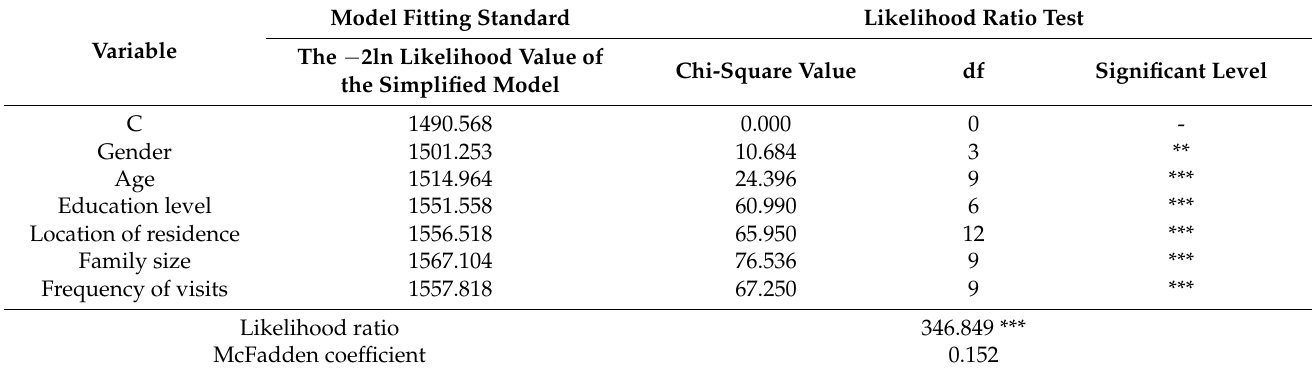
Table 4. Results of the model-fitting test and the independent